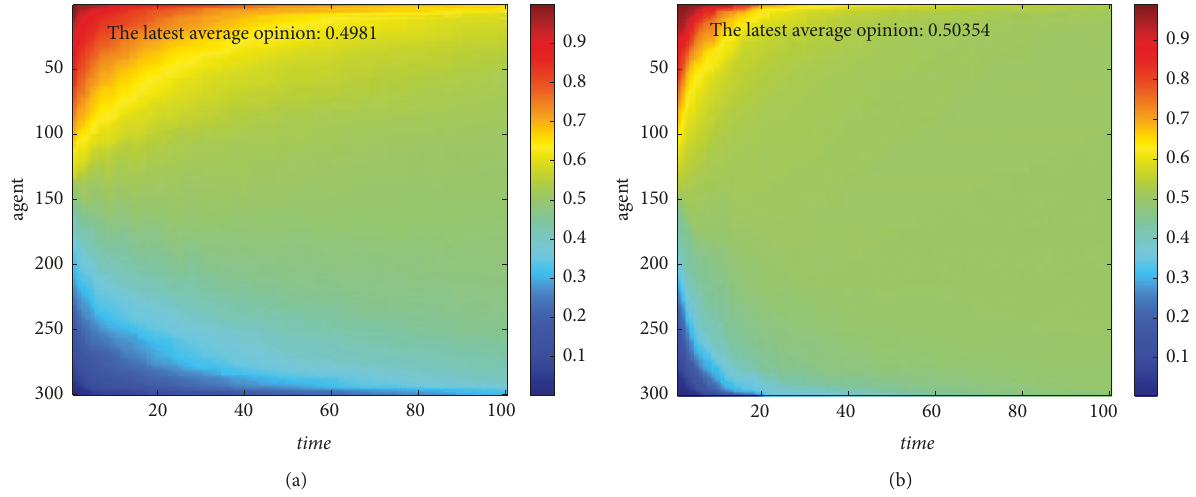
Figure 2: Comparison of the opinion distribution of the network with time. (a) A ( 0 ) ∼ U ( 0 , 1 ) , (b) A ( 0 ) ∼ U ( 0 , 0 . 1 )